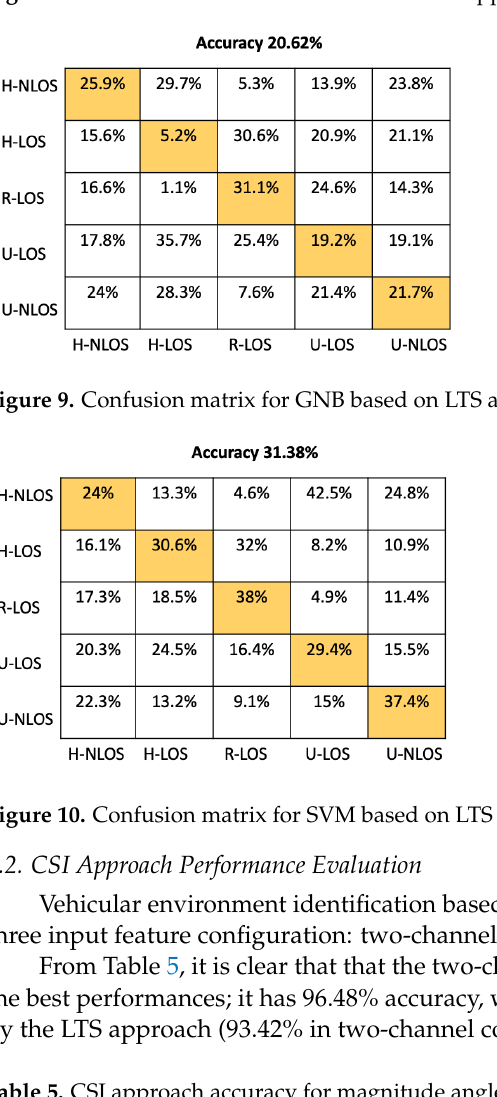
Figure 8. Confusion matrix for RF based on LTS approach.